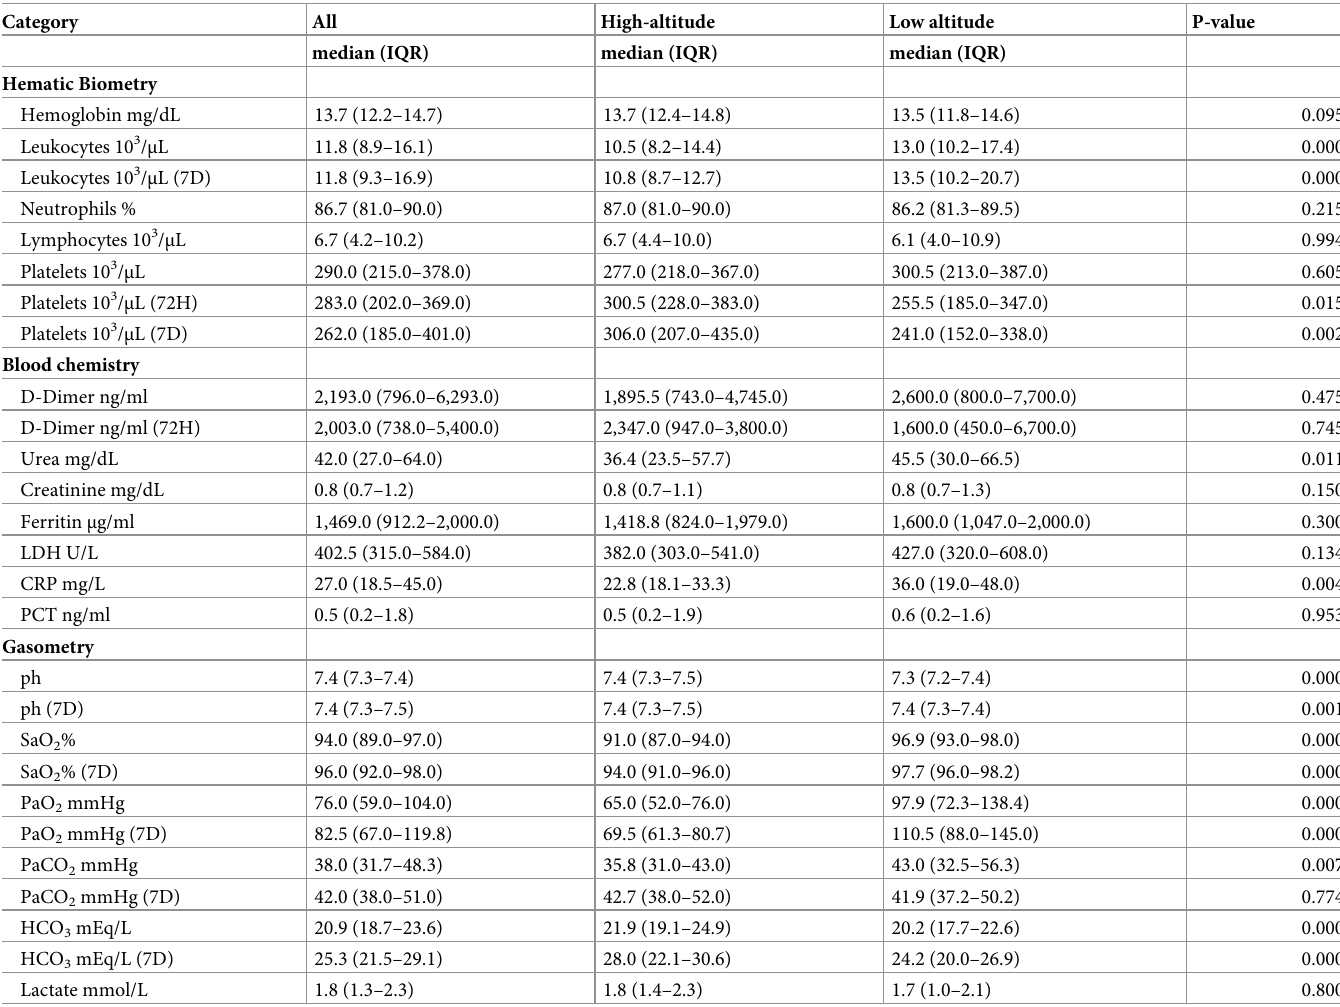
Table 3. Analysis of the mean and median differences of the principal hematological and serological parameters in severely ill patients with covid19. Category